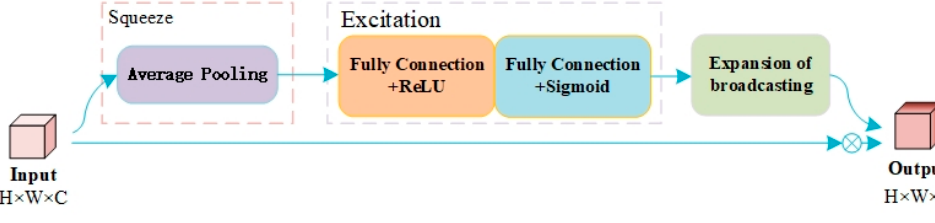
Figure 3. Structure of SE.